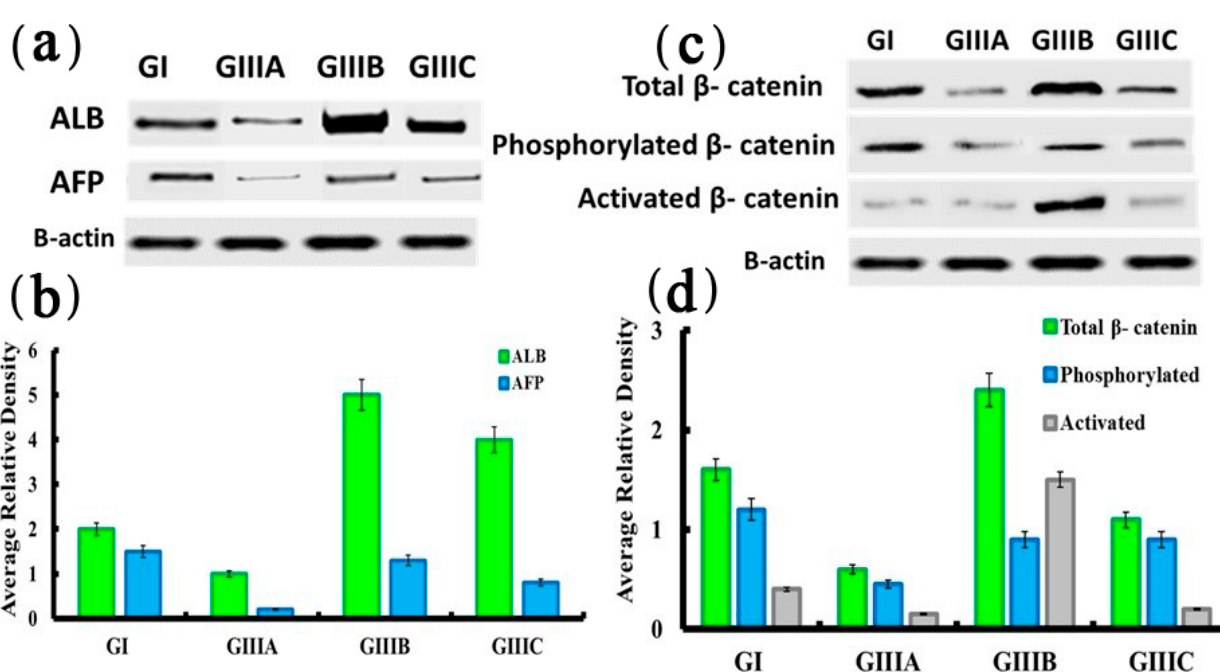
Figure 4. Protein expression of ALB, AFP and β -catenin (total, activated & phosphorylated) by western blot analysis ( a – d ). β -actin was used as housekeeping protein and quantification was performed using Image analysis software on the Chemi Doc MP imaging system. Data are shown as mean ± S.E.M, n = 7. GI (native liver), GIIIA (4 days recellularization), GIIIB (14 days recellularization) and GIIIC (24 days recellularization).